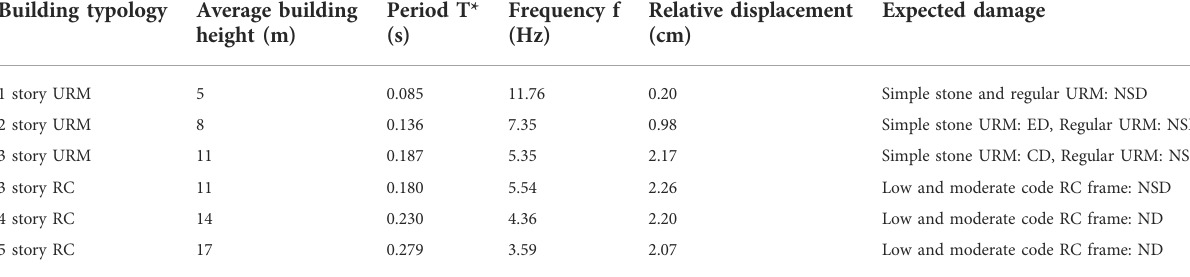
TABLE 3 Damage assessment for different building typologies for Norcia (1-3 story URM and 3-5 story RC buildings). Building